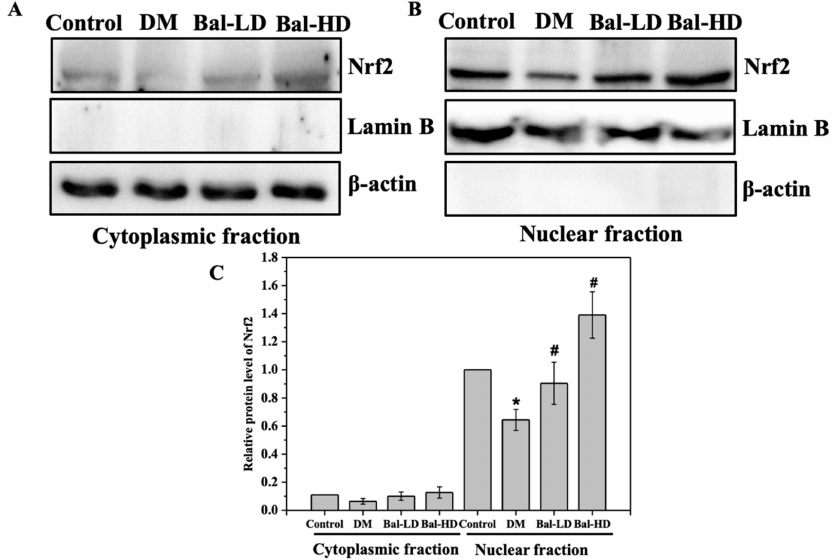
Figure 9. The subcellular localization of Nrf2 in the liver tissue of T2DM mice treated with baicalein. The liver tissues from normal mice (control group), mice model of T2DM (DM group), T2DM mice treated with 40 mg / kg / d of baicalein (Bal-LD group), and T2DM mice treated with 160 mg / kg / d of baicalein (Bal-HD group) were homogenized. The levels of the target proteins were determined by immunoblotting. Representative immunoblot of the Nrf2 in the cytoplasmic fraction ( A ) and nuclear fraction ( B ). Quantitative analysis and the statistical analysis of the protein levels of Nrf2 relative to the control group ( C ). Values are represented as the mean ± SD ( n = 3). * p < 0.05 vs. control group; # p < 0.05 vs. DM